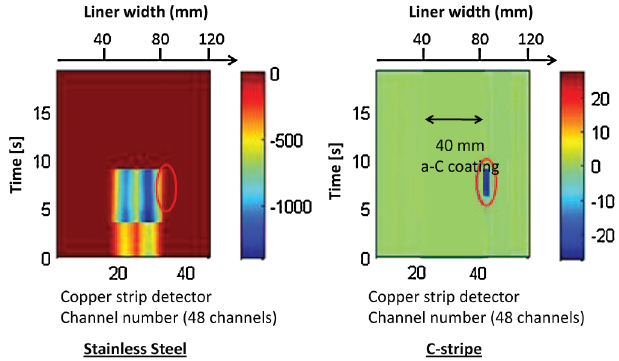
FIG. 7. ECM signals of StSt and a-C coating at different bunch spacings: 25, 50, and 75 ns. In MD8, the e-cloud signal on the C-Ne2 liner was well below the detection limit and was consid- ered as noise.